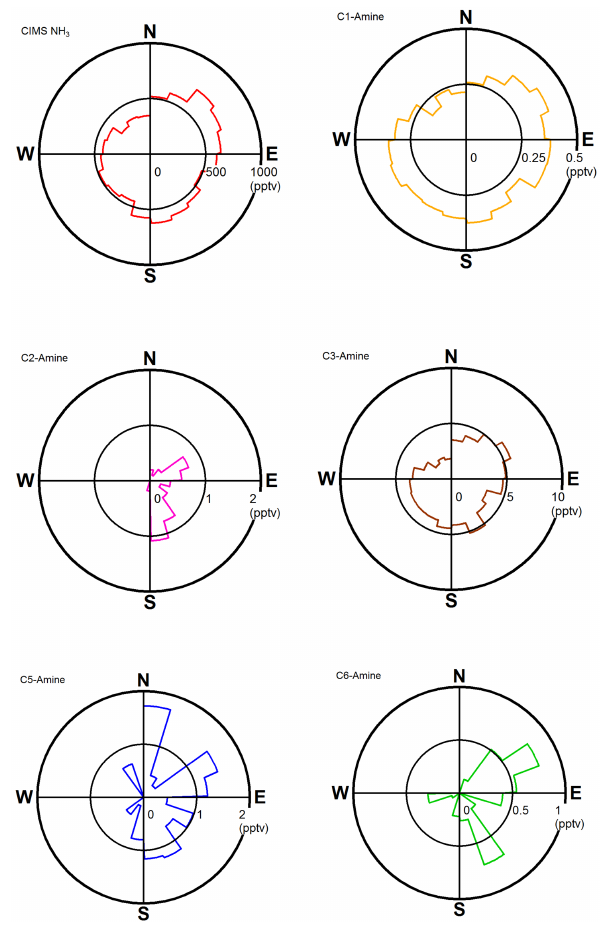
Figure 9. Wind direction plots of the measured amines and NH 3 , averaged over the entire SOAS campaign. C4-amines were rarely measured, so are not shown